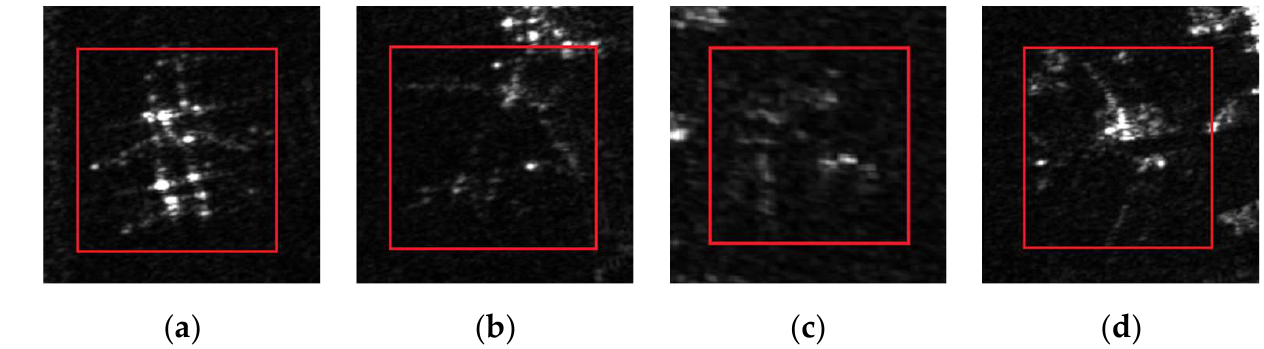
where, 𝒚 denotes the tensor after splitting, 𝐹 denotes the grouping convolution (cid:3041) 𝐺𝐶 function, 𝒑 is the intermediate feature tensor after concatenation , and 𝐹 and 𝐹 max avg denote the operation of calculating the maximum and average values, respectively. As shown in Figure 1, the SOAMs and the PAFPN are combined and a new neck network is obtained, called the SOEPAFPN, which is able to eliminate the conflict of fea- Figure 2. Aircraft with different azimuth angles in Gaofen-3 1 m images. Figure 2. Aircraft with different azimuth angles in Gaofen-3 1 m images. ( a ) Aircraft exhibiting tures between various scales and better integrate multiscale features. The feature pyramid discrete strong scattering points. ( b ) Aircraft exhibiting geometric contours. ( c ) Aircraft exhibiting network (FPN) [33] adopts a top–down mode to transfer high-level features downward, fuzzy contours. ( d ) Aircraft exhibiting fuzzy contours and isolated strong scattering points. but the path between high-level features and low-level features is long, thus increasing Considering the differences in scattering and geometric features of the same azimuth- the difficulty and burden of accessing accurate locating information. The PAFPN intro- sensitive object when imaging at different azimuths, the CAM is used to extract in different duces the path aggregation (PA) [25] strategy to the FPN, thus creating a bottom–up path directions information to eliminate the influence of azimuth. Global average pooling enhancement based on the FPN to shorten the information path, reduce the number of is decomposed into two parallel one-dimensional coding processes in the X-direction layers required to transmit features with various scales, reduce the cost of computing, and and the Y-direction; that is, the horizontal and vertical features are aggregated into two improve the locating accuracy. In particular, the SOAMs are connected to the concatenat- independent azimuth-aware feature maps to capture the differences in azimuth-sensitive ing process of upsampling and downsampling to reduce the loss of spatial orientation objects in different directions and integrate the spatial orientation information into the information after sampling. channel attention feature map. The specific structure is shown in Figure 3.